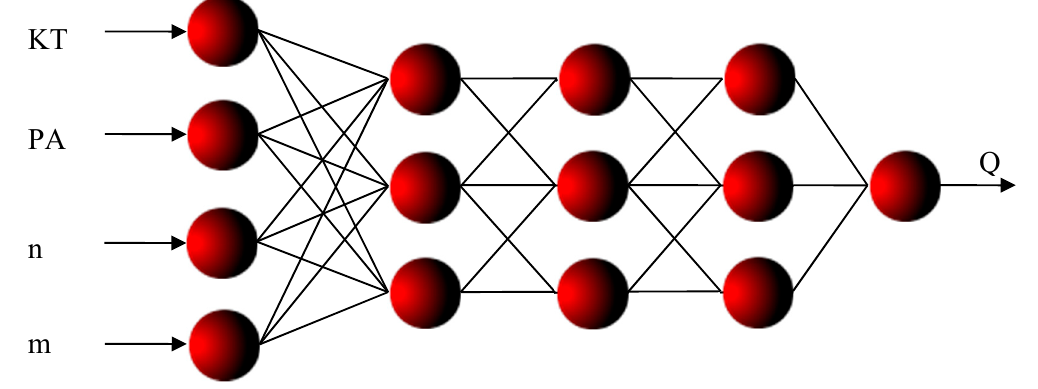
Figure 4. The topology of the AGENN model with [4-3-3-3-1] Artificial Neural Network.